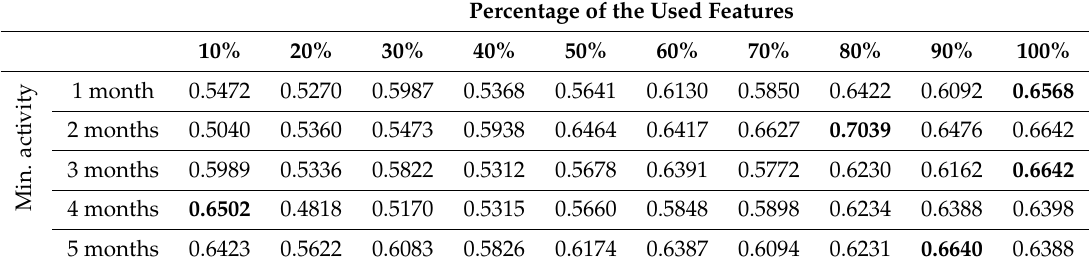
Table A1. F-score macro average for the Decision Tree classification of two levels of the hierarchy in the manufacturing company dataset. The values which are bolded are the best results for a given minimum communication activity.